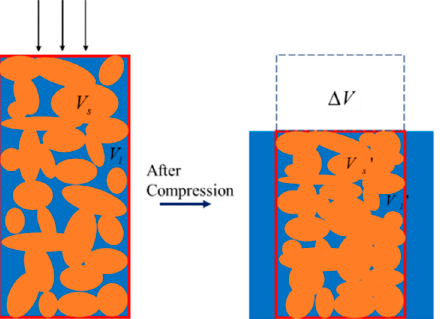
Figure 3. Control volume of the mixture before and after compression.